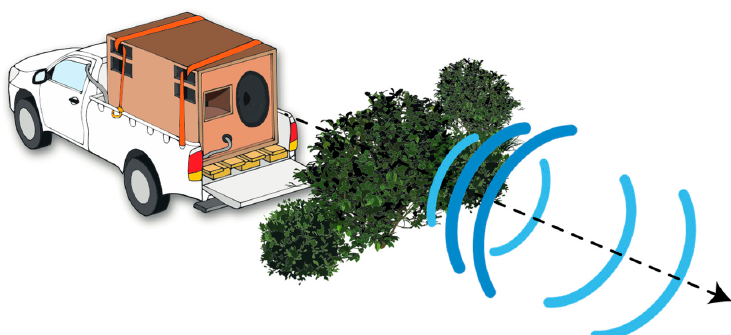
Figure 1. Schematic representation of the positioned infrasonic loudspeaker system at a densely vegetated location. The battery-supplied INFRA10 is mounted on the loading zone of a pick-up and operated inside the vehicle (broadcasting direction of playback stimulus indicated by dashed arrow).